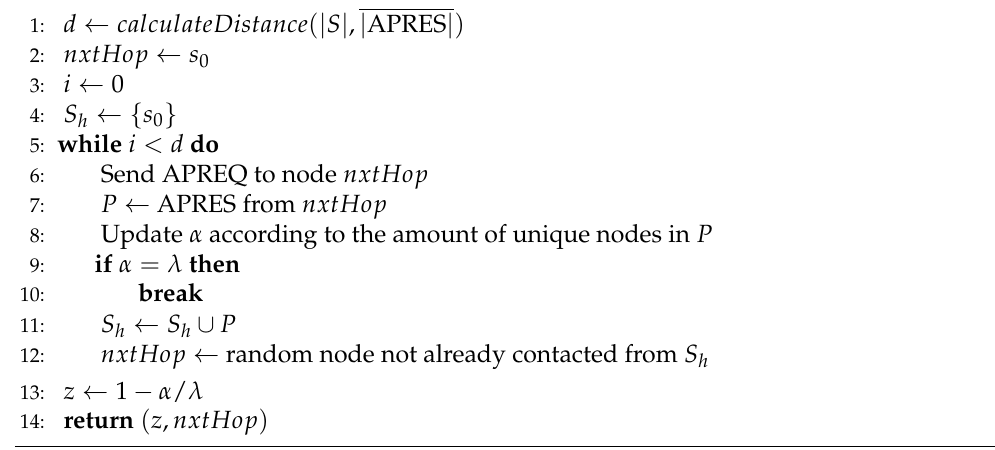
Algorithm 1 Aurora Algorithm